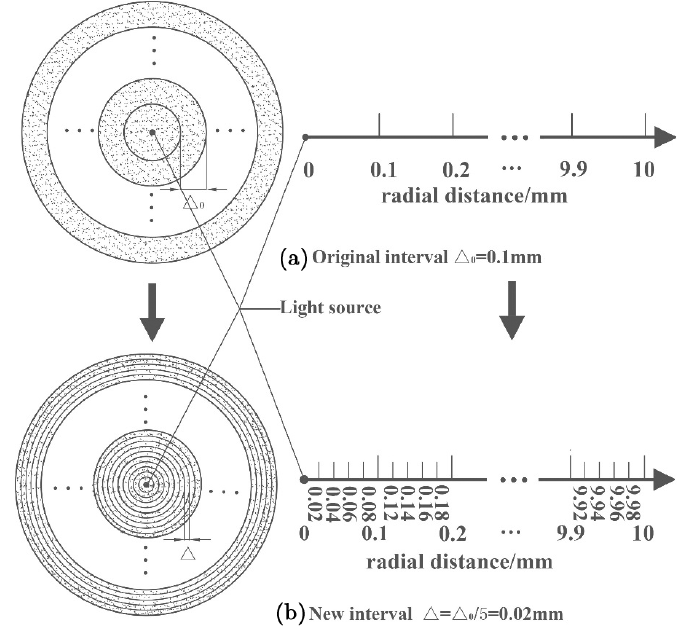
Fig. 2. Schematic of thinning the sampling interval: (a) original interval, the left represents vertical view and the right represents side view; (b) new interval, the left is vertical view and the right is side